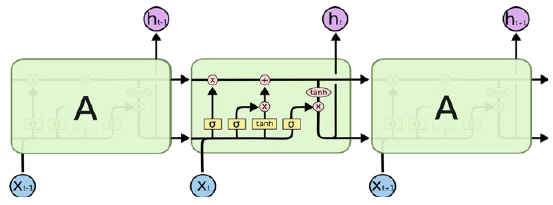
Fig. 7. The repeating module in an LSTM contains four interacting layers (Adapted from (Zhai et al.,